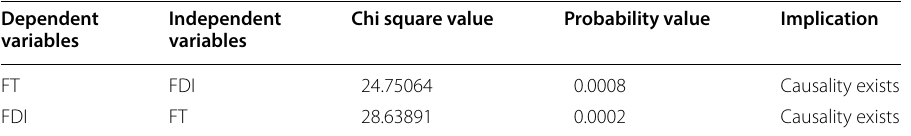
Table 9 Result of VEC Granger causality/block exogeneity Wald test for FDI and FT. Source: Calculated by authors